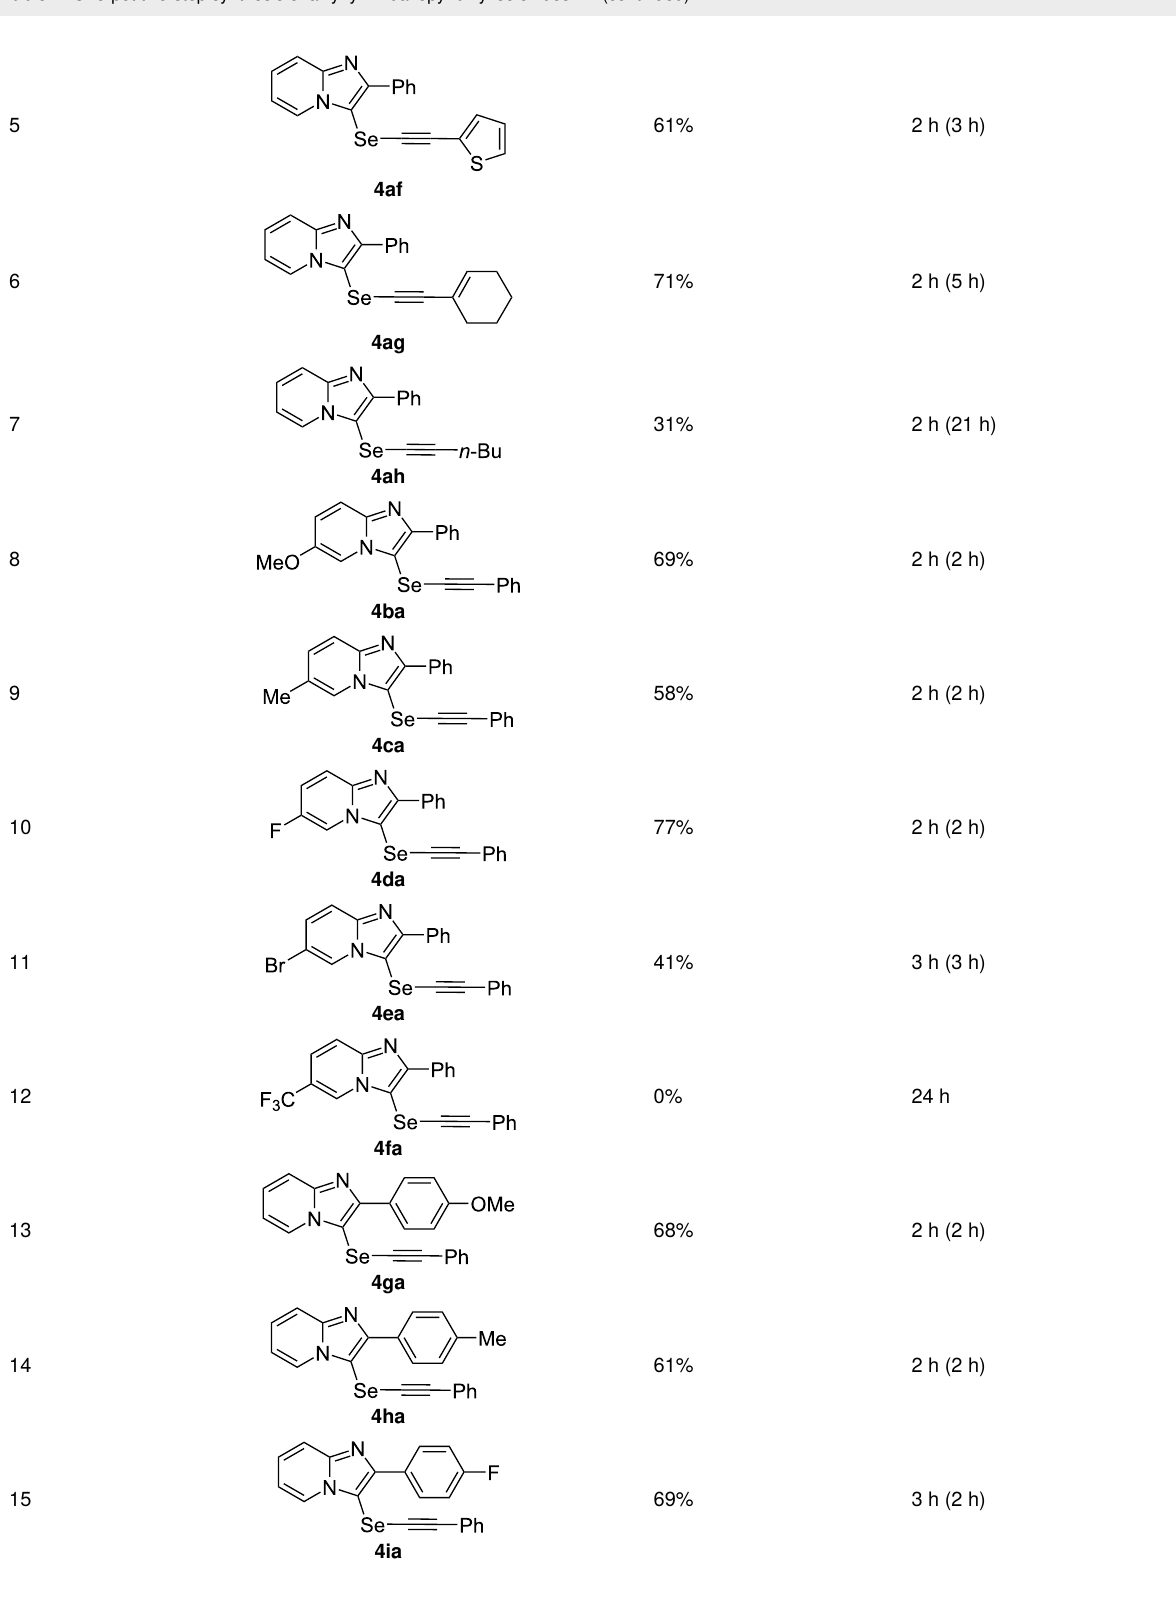
Table 2: One-pot two-step synthesis of alkynyl imidazopyridinyl selenides 4 a .